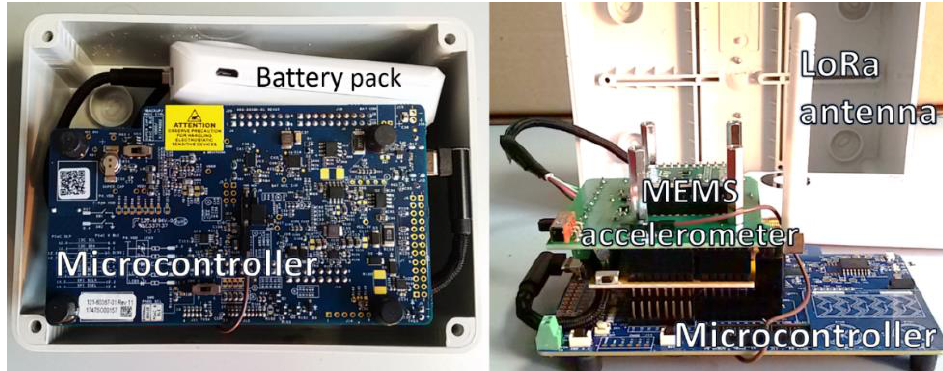
Figure 2. Pictures of the assembled electronic components and battery of the sensor node.